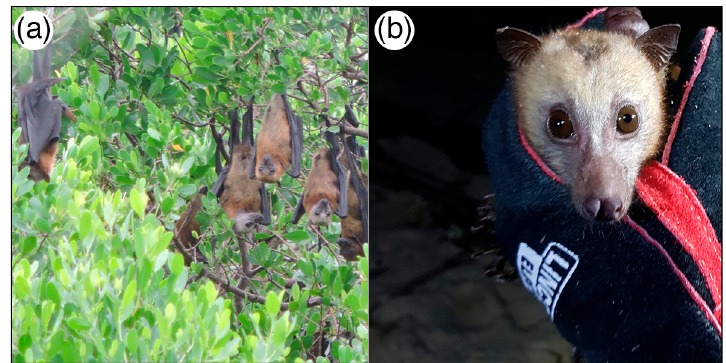
Figure 2. ( a ) Pteropus griseus roosting in the mangrove swamp showing ventral coloration; and ( b ) P. griseus in hand, showing light head coloration.